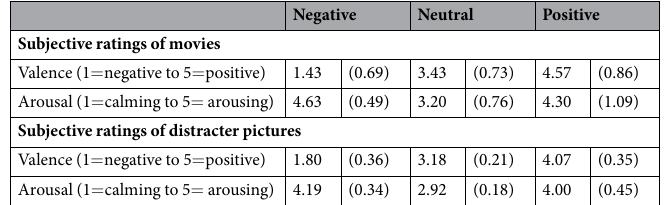
Table 2. Means and standard deviations (in parenthesis) of subjective ratings of movie clips and pictures employed as